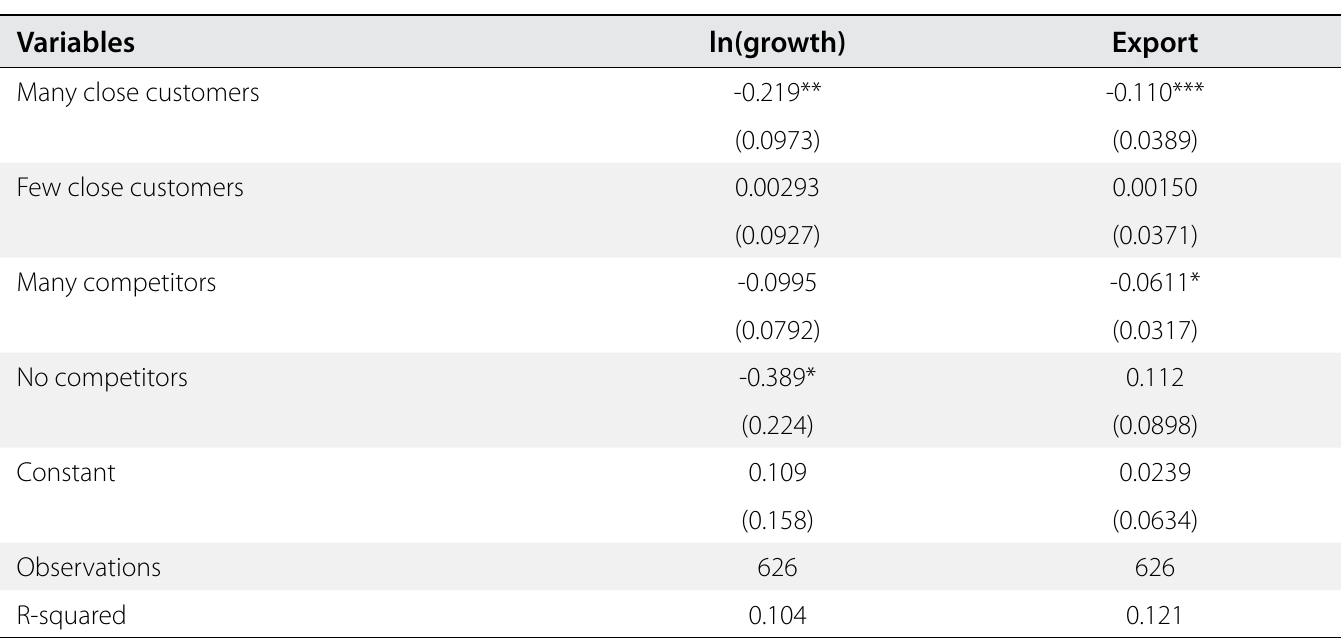
Table 3: Regression Results continued